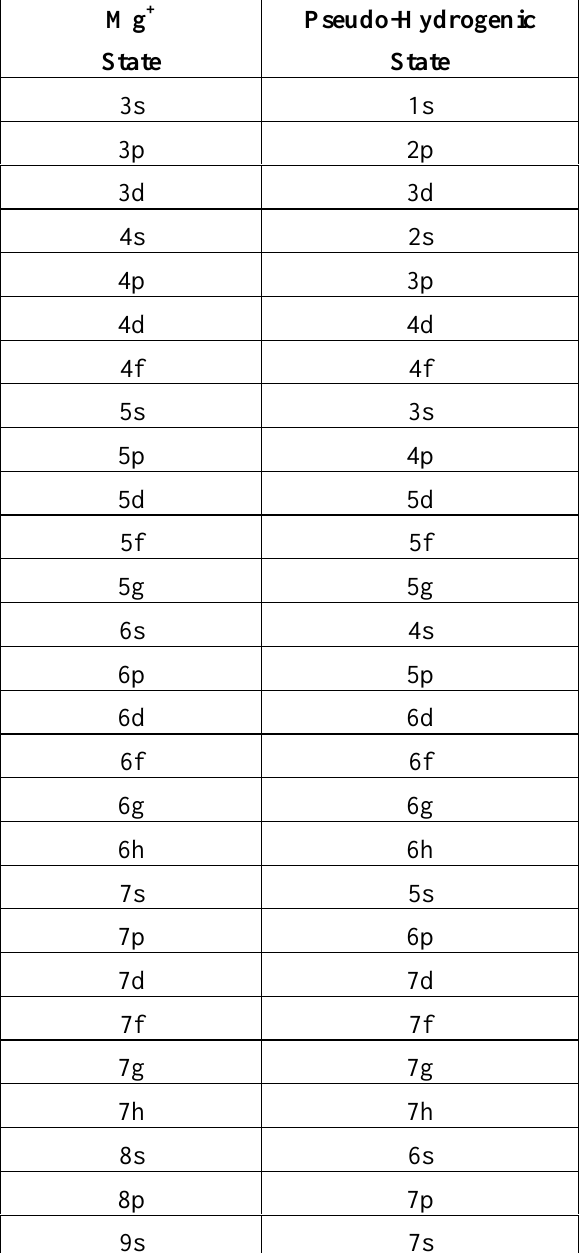
Table II. Mg + electronic states and their corresponding pseudo-hydrogenic